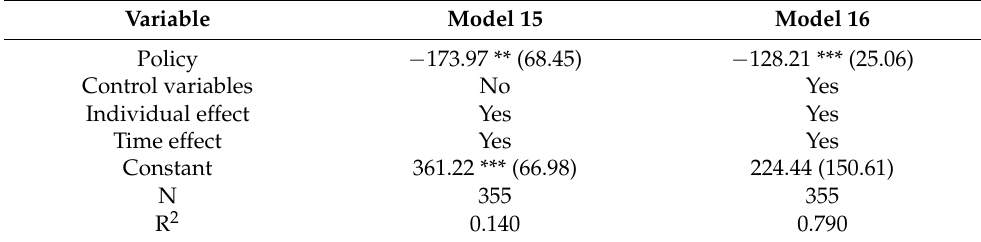
Table 9. Net effect test of carbon trading system after matching.